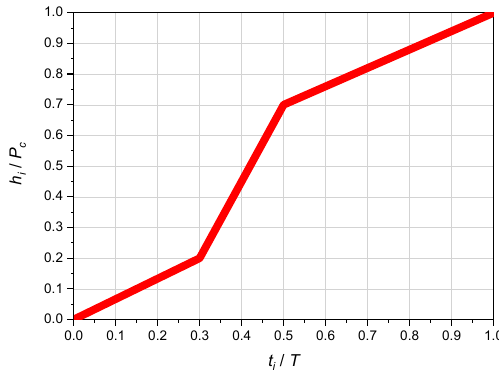
Figure 3. Recommended distribution of rainfall sums according to DVWK [44].